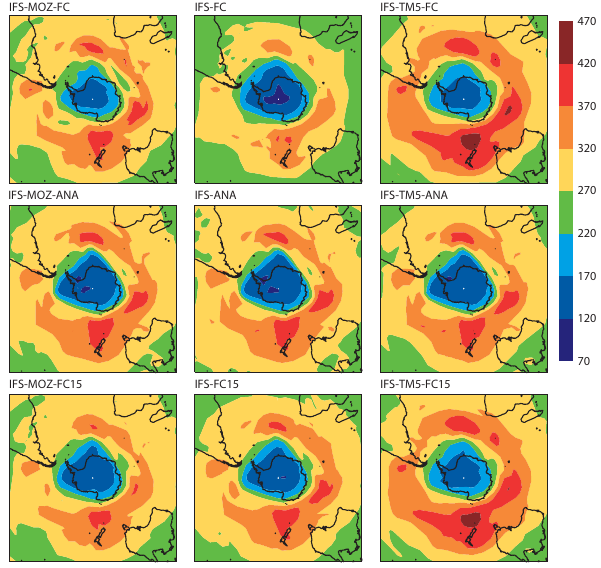
Fig. 8. Ozone total columns (DU) over Antarctica on 30 Septem- ber 2008, 12:00UTC, from the runs without assimilation (FC, top), with assimilation (ANA, middle) and from runs initialized 14 days previously (FC15, bottom) by IFS-MOZART, by IFS and by IFS- TM5. Blue colours indicate low values below 220DU; red and dark red colors indicate values above